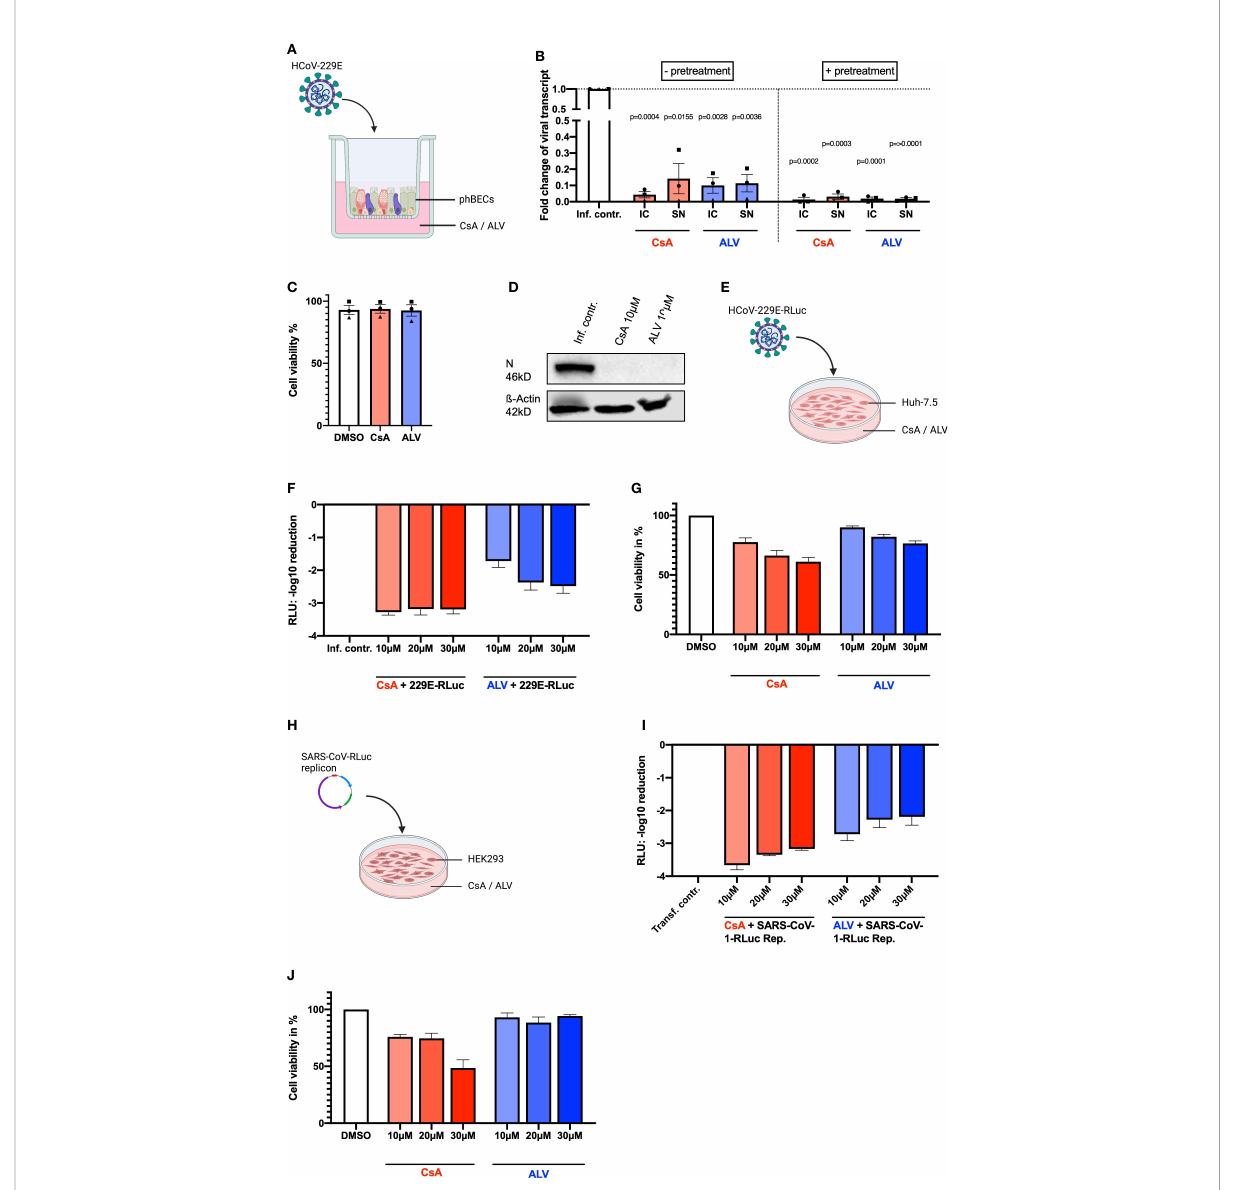
FIGURE 1 Inhibitory effects of CsA and ALV in different human infection models. (A) Illustration of phBEC infection with HCoV-229E, created with biorender.com. (B) RT-qPCR results of (for 72 h) HCoV-229E infected (MOI = 4) phBECs (n = 3, independent donors) with and without pretreatment in presence of compound CsA and ALV at 10 µM, given as fold changes of intracellular (IC) and supernatant (SN) viral transcript relative to the infection control (inf. contr.), HCoV-229E-infected phBECs treated with the vehicle DMSO (normalized to 1 for both IC and SN). Intracellular: Normalized to the housekeeping gene DEAH-Box Helicase 8 ( DHX8 ). The symbols each represent an independent donor (circles = donor 1; squares = donor 2; triangles = donor 3). For statistical analysis, a paired two-tailed t-test was used and absolute p -values are given for p < 0.05. (C) Cell viability was assessed in the absence of virus by the LDH assay after 48 h pretreatment plus 72 h mock infection in percent. Both mock-infected and coronavirus-infected cells had been pretreated with 10 µM inhibitor in medium for 48 h until infection. Following infection the basolateral medium was fully removed and fresh medium with the same inhibitor concentration (i.e., 10 µM) added, keeping the concentration constant at any given timepoint. (D) Representative immunoblot analysis of HCoV-229E N protein and loading control b -actin. (E) Illustration of Huh-7.5 infected with a variant of HCoV-229E expressing Renilla luciferase. Figure was created with biorender.com. (F) HCoV- 229E infection of Huh-7.5 cells for 48 h: Renilla luminescence was quanti fi ed as a measure of viral replication. The results are shown in log scale (log 10 reduction). (G) Cell viability of Huh-7.5 cells after 48 h of inhibitor treatment was measured using the Celltiter-Glo assay and is shown in percent. (H) Illustration of transfection of HEK293 cells with a pBAC-SARS-Rep-Rluc plasmid expressing Renilla luciferase. Figure was created with biorender.com. (I) pBAC-SARS-Rep-Rluc transfection into HEK293 cells for 48 h: Renilla luminescence was quanti fi ed as a measure of viral replication. The results are shown in log scale (log 10 reduction). (J) Cell viability of HEK293 cells after 48 h of inhibitor treatment measured with the Celltiter-Glo assay. All results are shown as mean ±